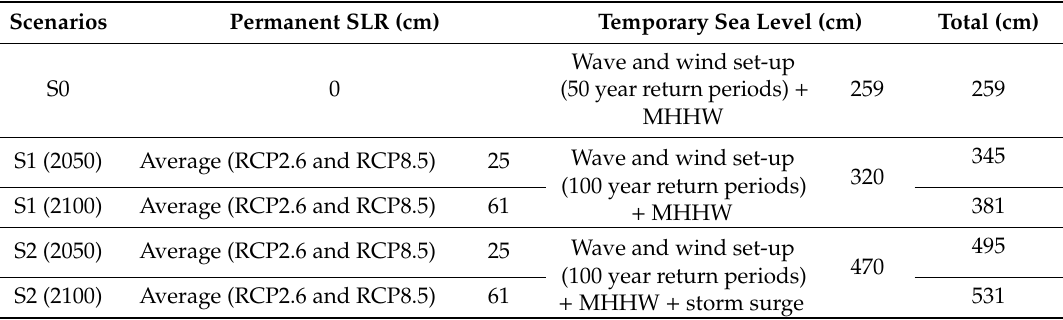
Table 1. Flooding scenarios in the study